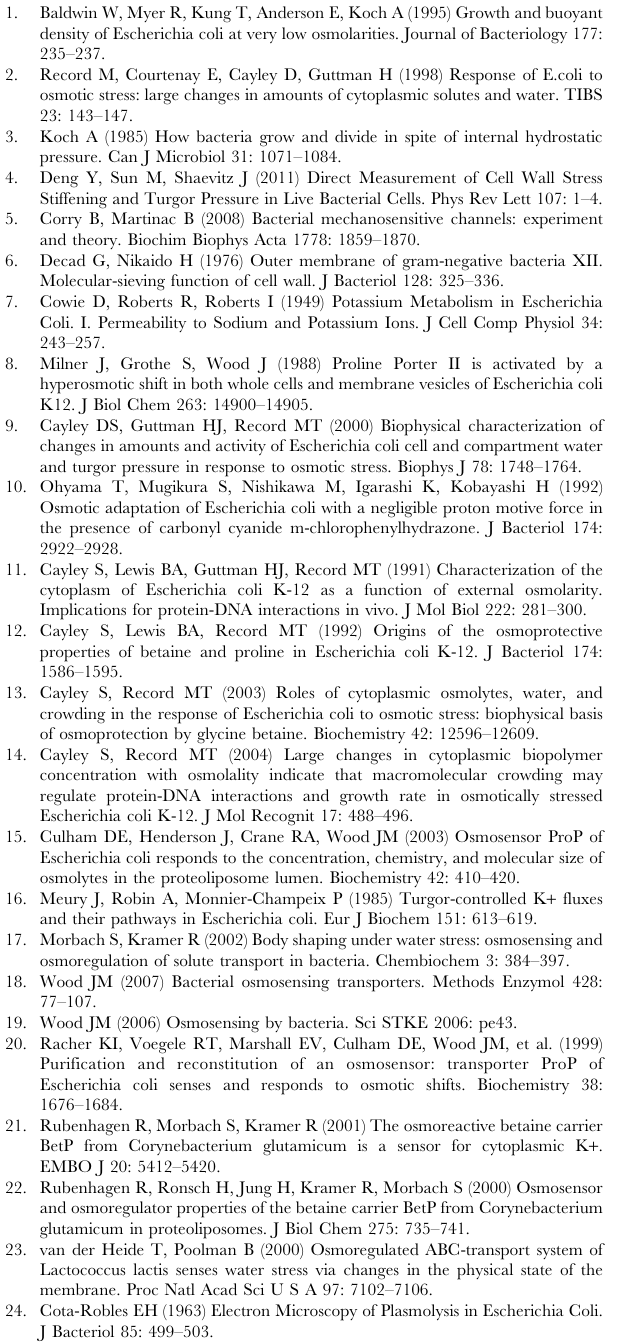
and total cell volume by the red outer membrane dye FM4-64. Images were acquired at a frame every 1.6 seconds alternating between the cytoplasmic volume and total cell volume. Video S2 Composite images constructed from the fluorescent images in Video S1. Image brightness was adjusted due to photo bleaching and the difference in fluorescence intensity between the red and green channels. Cytoplasmic volume is given in green and total cell volume in